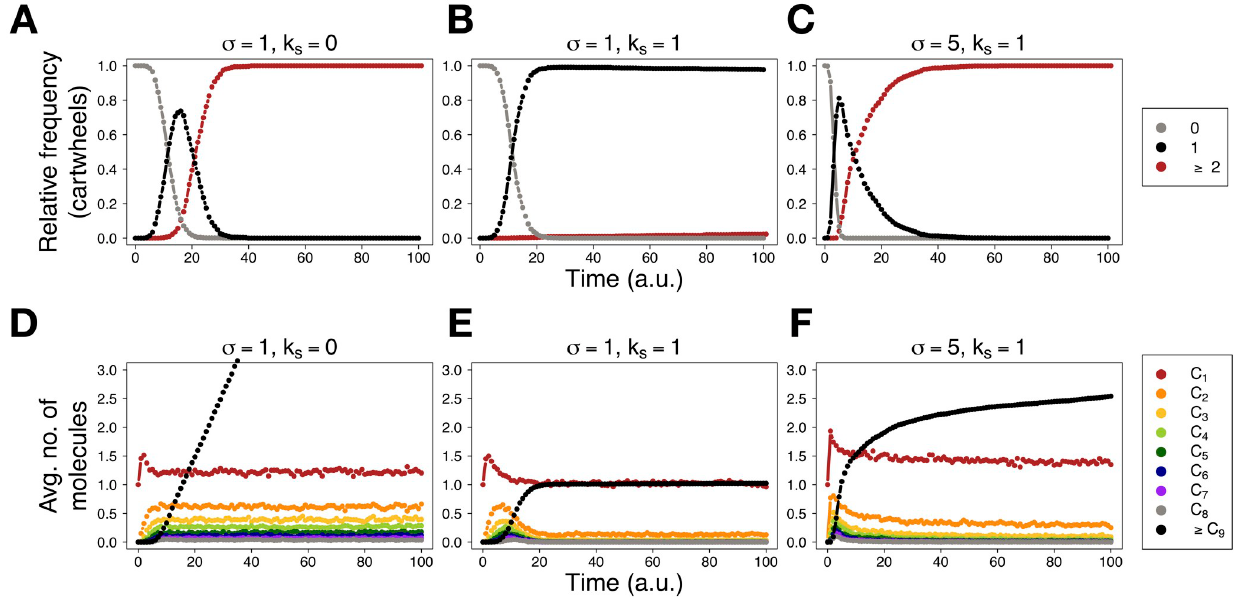
Fig 3. Stacking causes depletion of intermediates and inhibits the formation of supernumerary cartwheels. (A-C)—relative frequency of simulations containing 0 (grey), 1 (black), and 2 or more (red) cartwheels as a function of time, for the indicated values of σ and k s . (D-F)—average number of . We performed 1000 simulations with no SAS-6 molecules molecules across all simulations, as a function of time, for the indicated values of σ and k s initially present and stopped them at time t = 100; time t is measured in arbitrary units (a.u.). For all simulations, k on = k off = 1. Note that k s = 0 represents absence of stacking. See also Models and methods section for default initial and stopping conditions, and parameter values for the simulations.